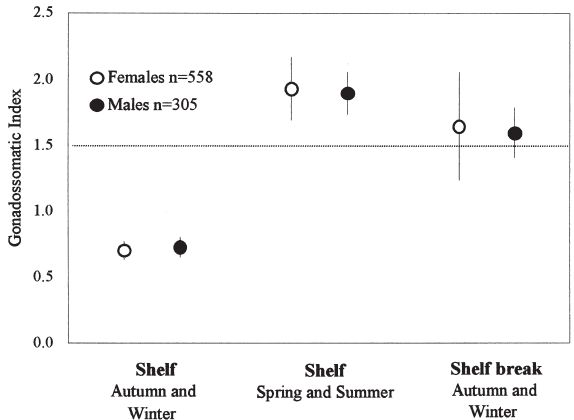
G equal or higher than 2.0 in 100 mm in 10 cm L classes and logistic F IG . 6. – Mean gonadosomatic indices ( I ) shelf break samples of Trichiurus lepturus in southern Brazil at dif- m ferent times of the year (vertical lines represents 95% confidence